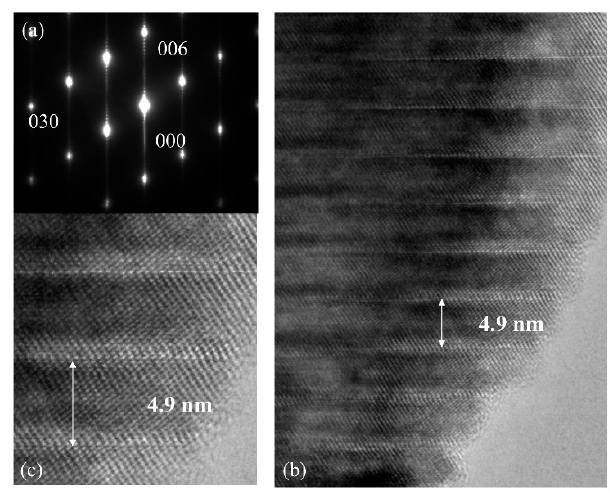
Figure 4. TEM images taken from the [100] axis and the selected area electron diffraction (SAED) pattern of LNT with Ti 20 mol % at 1373 K for 30 min under 0.35 MPa. ( a ) SAED pattern, ( b ) low-TEM image and ( c ) high-TEM image.